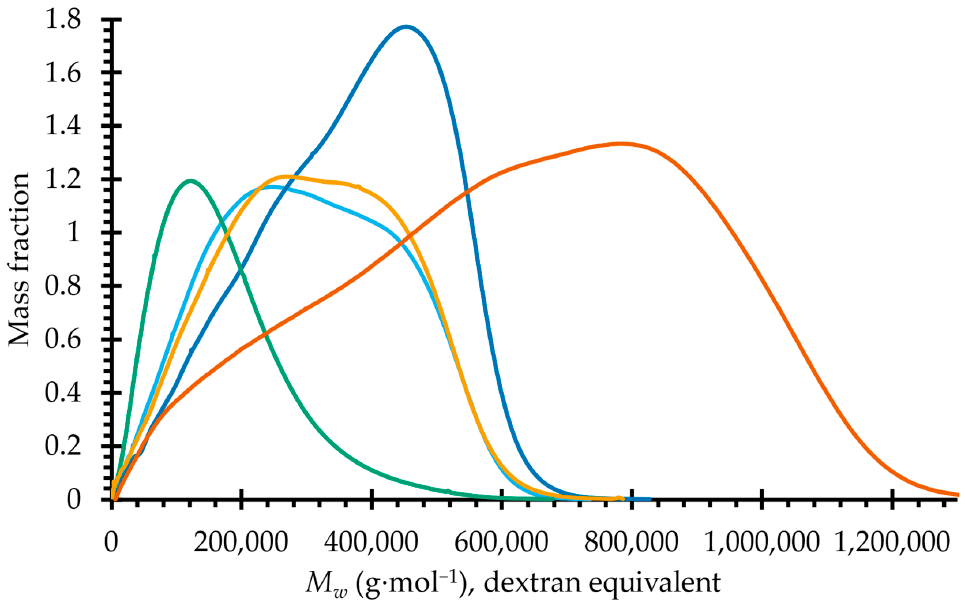
Figure 2. Molar mass distribution of the mucilage of O. joconostle and the polysaccharides found after IEC fractionation. Orange, OXO M; Sky blue, OXO N; Blue, OXO 0.2; Green, OXO 0.4; Yellow, OXO 1.0. Table 2. Monosaccharide composition and total carbohydrate content of the heteropolysaccharides that compose the mucilage extracted from the cladodes of O. joconostle